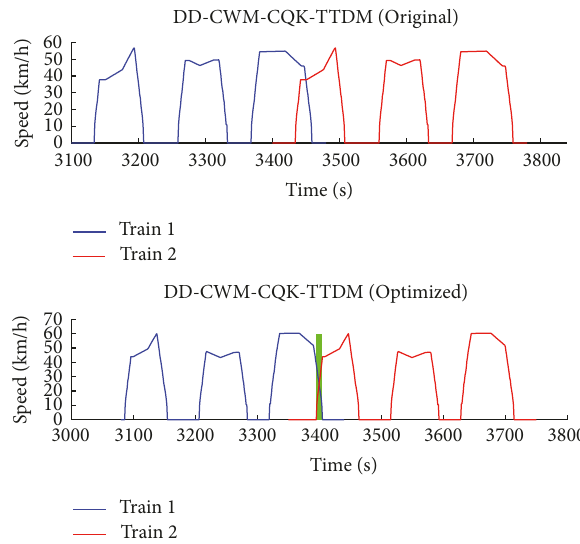
Figure 18: Synchronized traction and braking train in one power supply